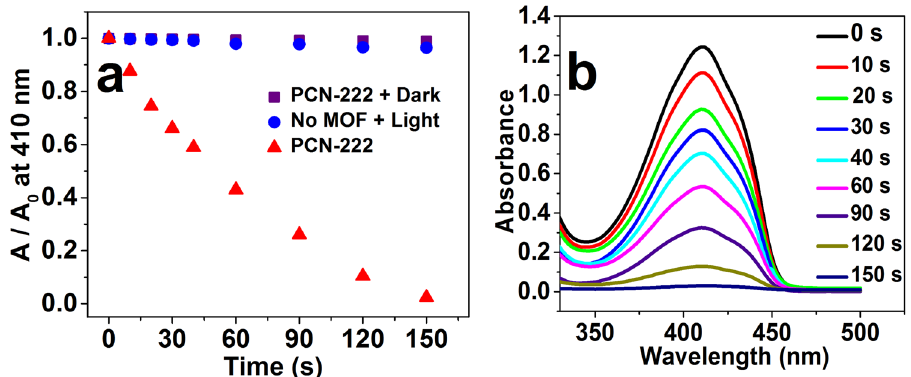
Figure 5. ( a ) Absorbance decay of the reacted DPBF solution. ( b ) The corresponding spectra in the presence of PCN-222. In every experiment, 2 mg PCN-222 was added to 10 mL the initial concentration of 60 µ M DPBF acetonitrile solution (with O 2 bubbled). Visible light irradiation conditions: wavelength range of 480–700